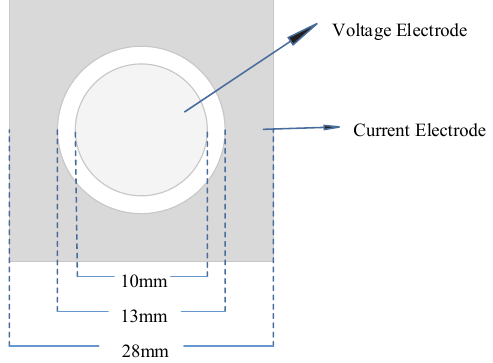
Fig. 3. A compound electrode uses an outer electrode to inject current and an inner electrode to measure voltage as redrawn from